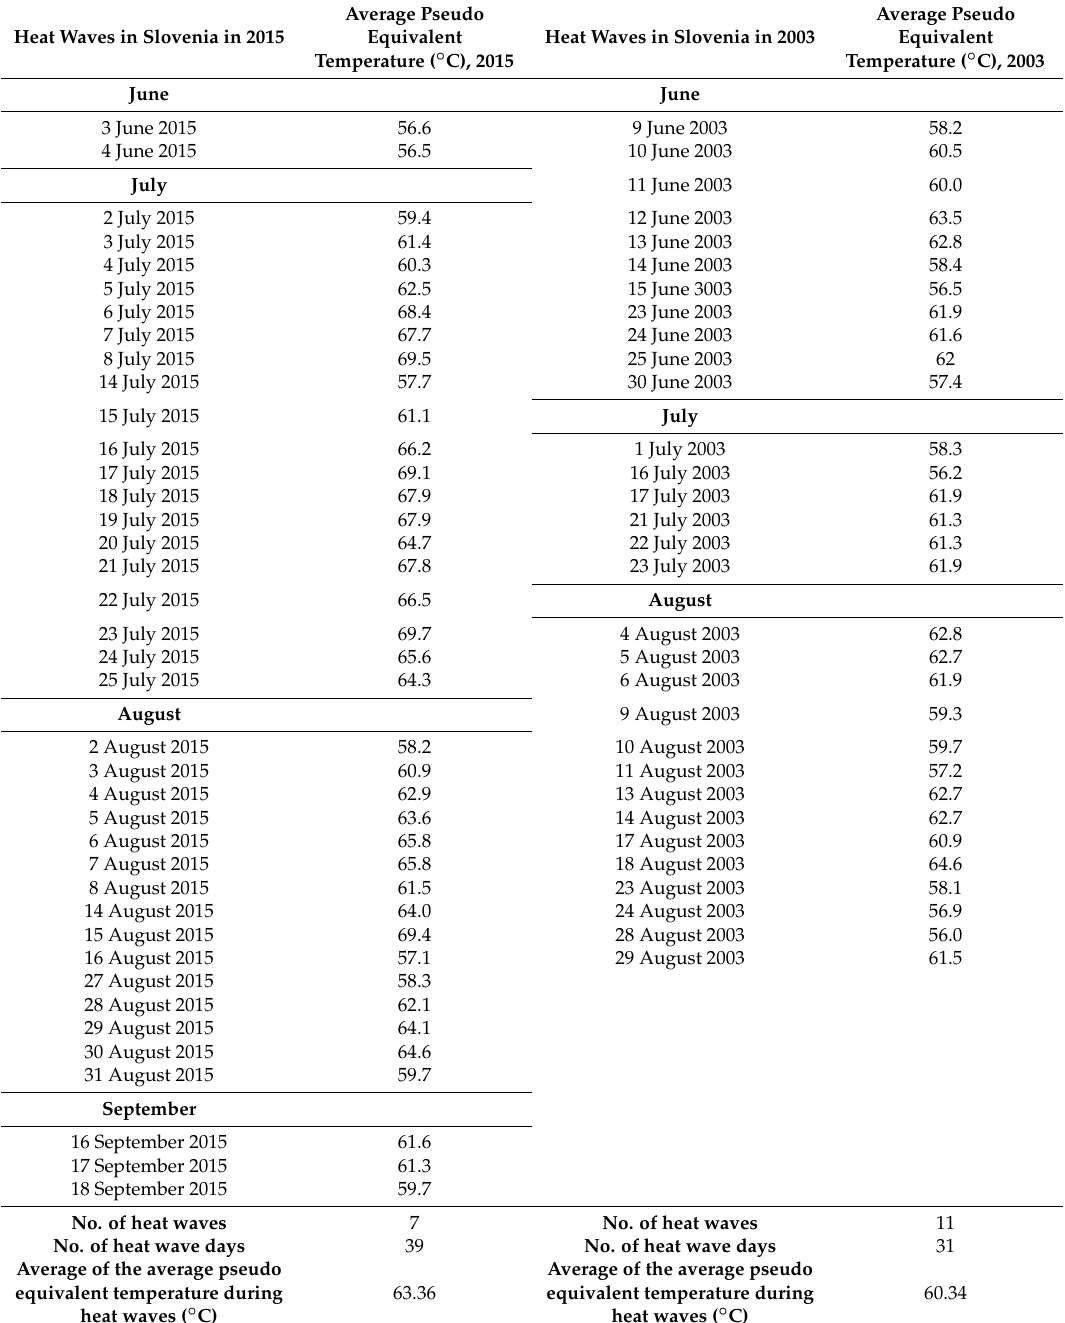
Table 1. Heat waves periods and pseudo equivalent temperature in Slovenia between 1 May and 30 September in 2015 and